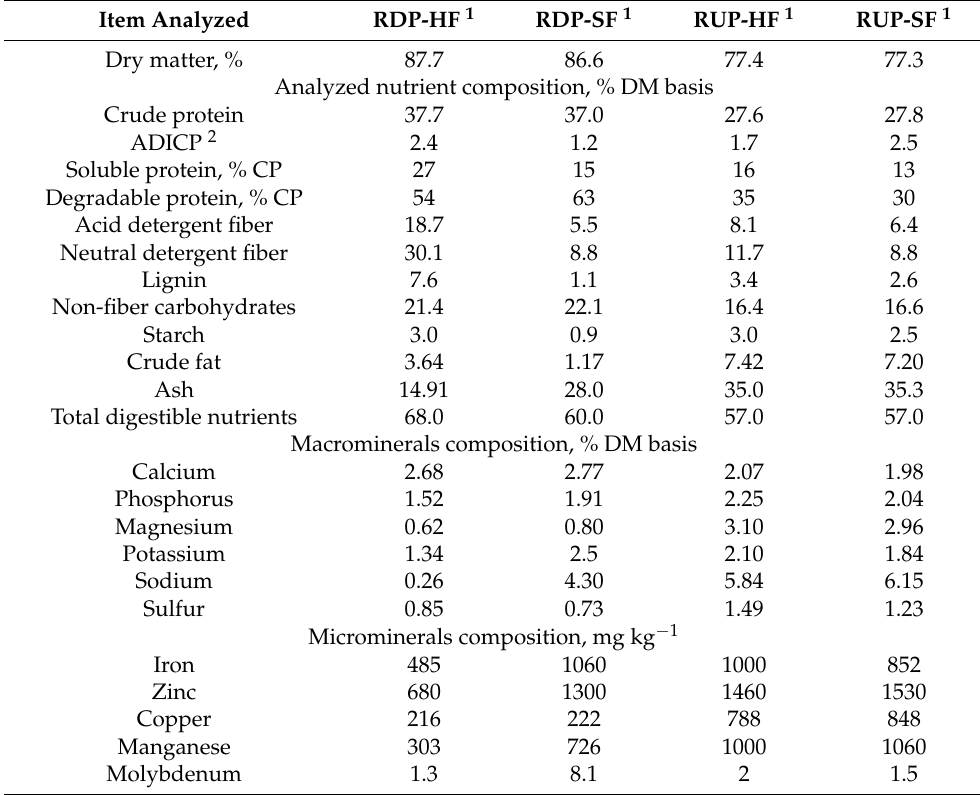
Table 1. Supplement nutrient analysis of supplements offered to fistulated 2- and 3-year-old beef